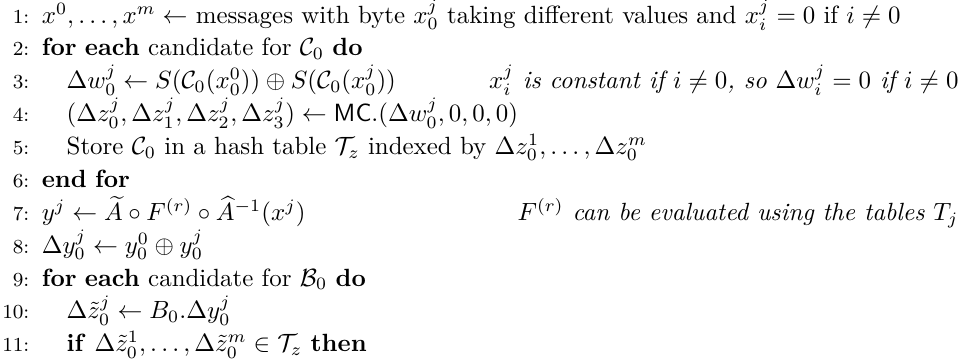
Algorithm 3 Identifying correct